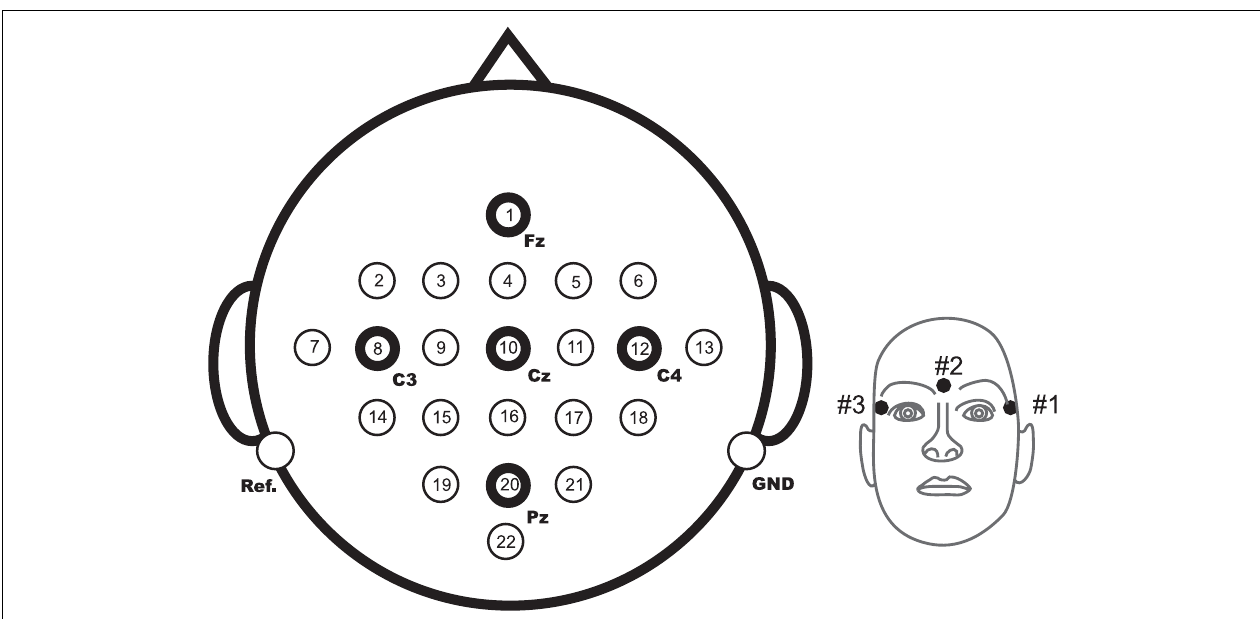
FIGURE 17 | (Data Set 2a). Left: electrode montage corresponding to the international 10–20 system. Right: electrode montage of the three monopolar EOG channels.